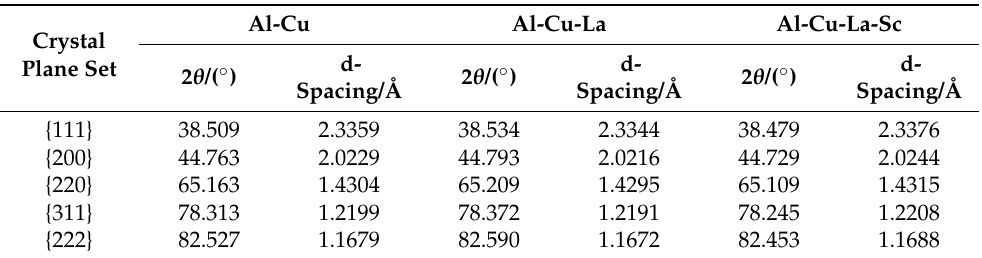
Figure 7. XRD patterns and α -Al lattice constants of Al-Cu, Al-Cu-La, Al-Cu-La-Sc alloys. Table 2. The d-spacing and diffraction angle of different crystal plane set in Al-Cu, Al-Cu-La, Al-Cu-La-Sc